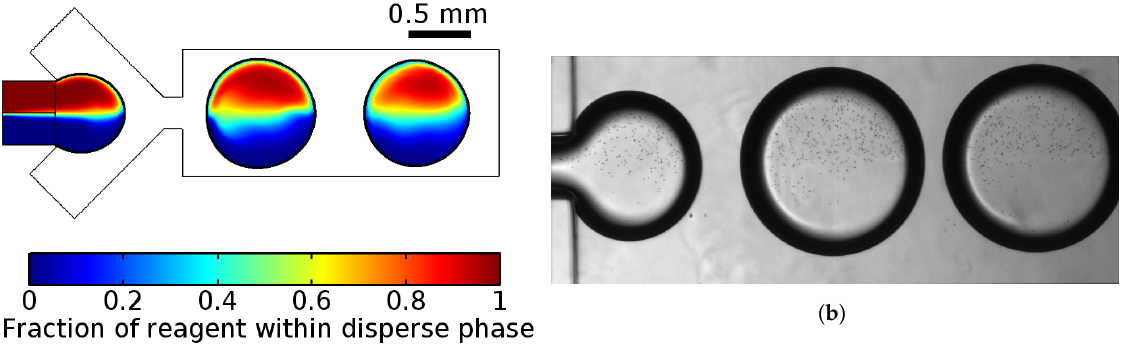
Figure 2. Droplet formation from the two co-laminar flows of the basic and starting solutions. The results of the 2D numerical simulation of the droplet generation with a diameter of 0.8mm in a channel 1mm wide with a frequency of 12 drops per minute ( a ) showed that the mixing of laminar flows that are equal in volume was insignificant during the formation of droplets and their further flow along the straight channel. This result was experimentally confirmed for a droplet generator with a channel depth of 0.25mm ( b ). For visualization, polymer microparticles with a nominal diameter of 1 µ m were added to one of the